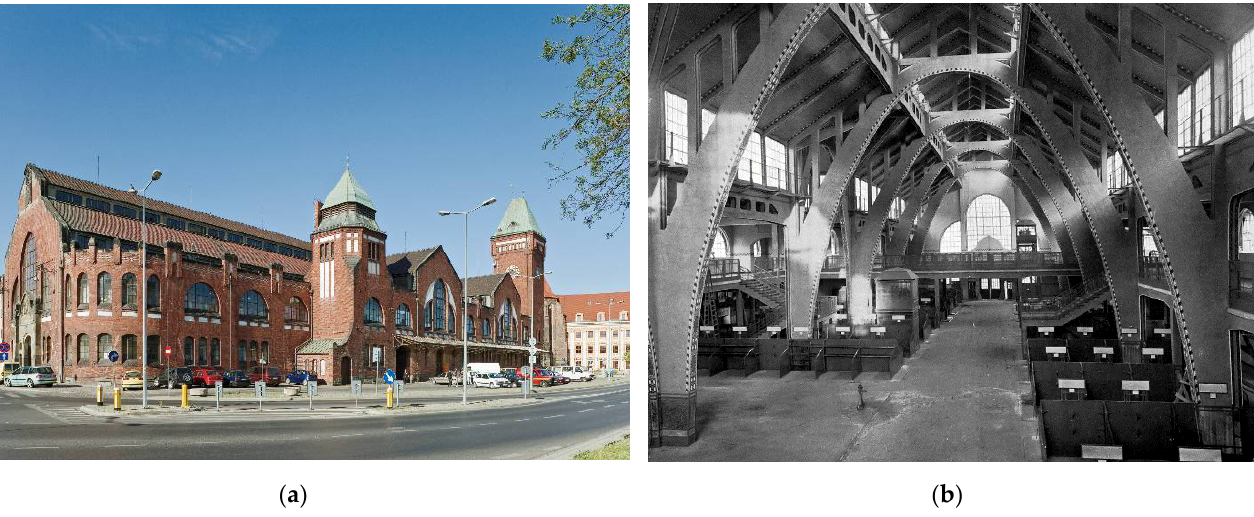
Figure 3. The Market Hall, built in 1907–1908 and designed by Richard Plüdemann and Heinrich Küster: ( a ) contemporary view (photo S. Klimek) and ( b ) interior view (Küster 1909, p. 97).